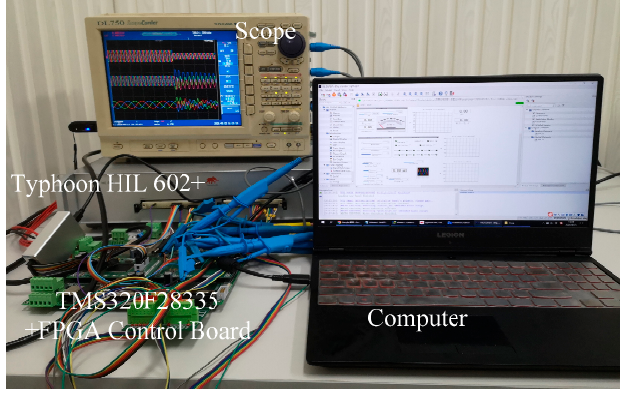
Figure 6. The experimental platform for 2MW DFIG system.